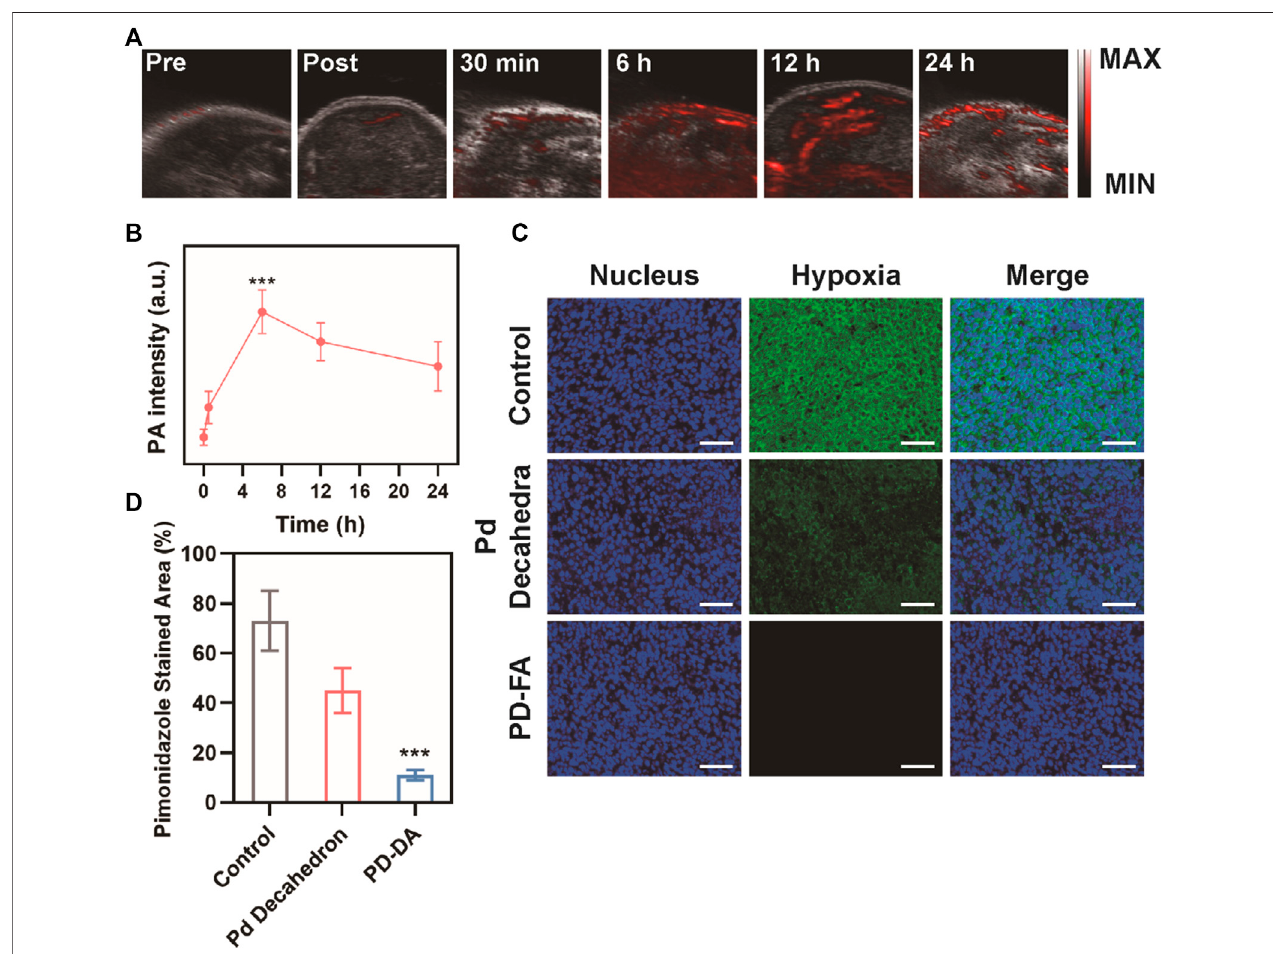
FIGURE 3 | Assessment of the in vivo PD-FA-mediated alleviation of intratumoral hypoxia. (A) PA images of tumors pre-injection and at 30 min, 6, 12, and 24 h post-injection, with (B) corresponding PA signal intensity analysis. (C) immuno fl uorescence-stained tumor sections following the indicated treatments with (D) corresponding quanti fi cation of pimonidazole fl uorescence (sacle bar: 50 μ m).